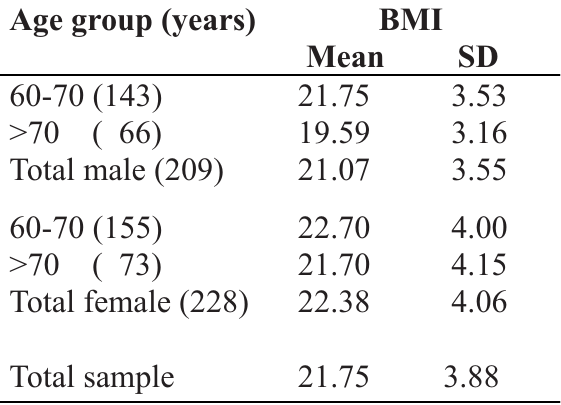
Table 1: BMI according to age group and